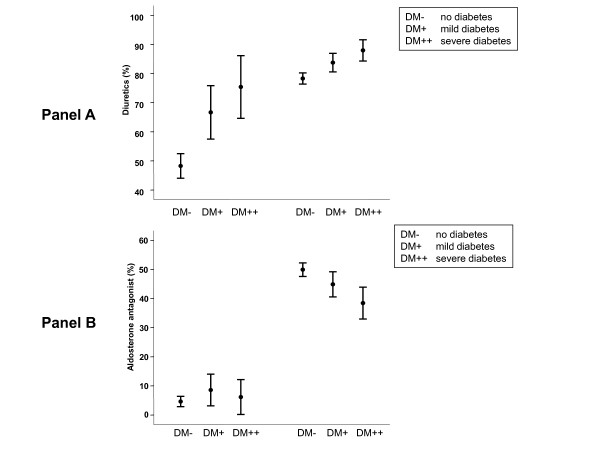
Percentage of patients without diabetes (DM-), with mild diabetes (DM+, on diet or taking oral anti-hyperglycaemic drugs) and with severe diabetes (DM++, insulin-dependent diabetes) receiving different drugs (mean, 95% confidence interval). Panel A shows prevalence of treatment with diuretics, panel B shows therapy with aldosterone receptor blockers. Data are separated by ejection fraction: Left side preserved ejection fraction (EF ≥ 50%), right side reduced ejection fraction (EF <50%).